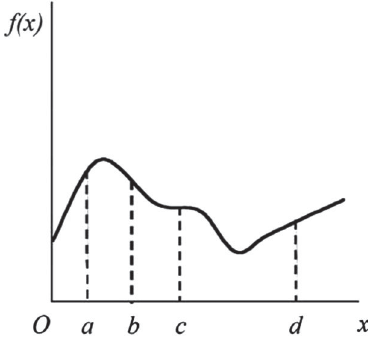
FIG. 2. Student response from the Slope Ranking Task indi- cating a ranking consistent with the average slope between FIG. 1. Slope Ranking Task. points rather than the instantaneous slope at each